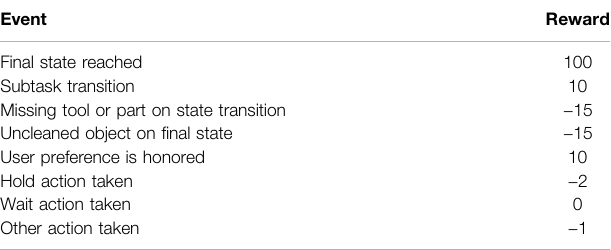
TABLE 1 | Rewards used to train the policy on the POMDP model derived from the